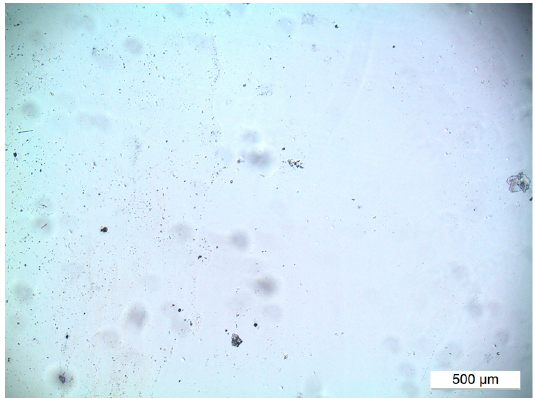
Figure 11. No viable cells or tubule formation could be observed in the angiogenesis assay with magnesium implants covered with PCL. Cell shed detached at Day 3. Scale bar: 500 µm, magnification of 40×.